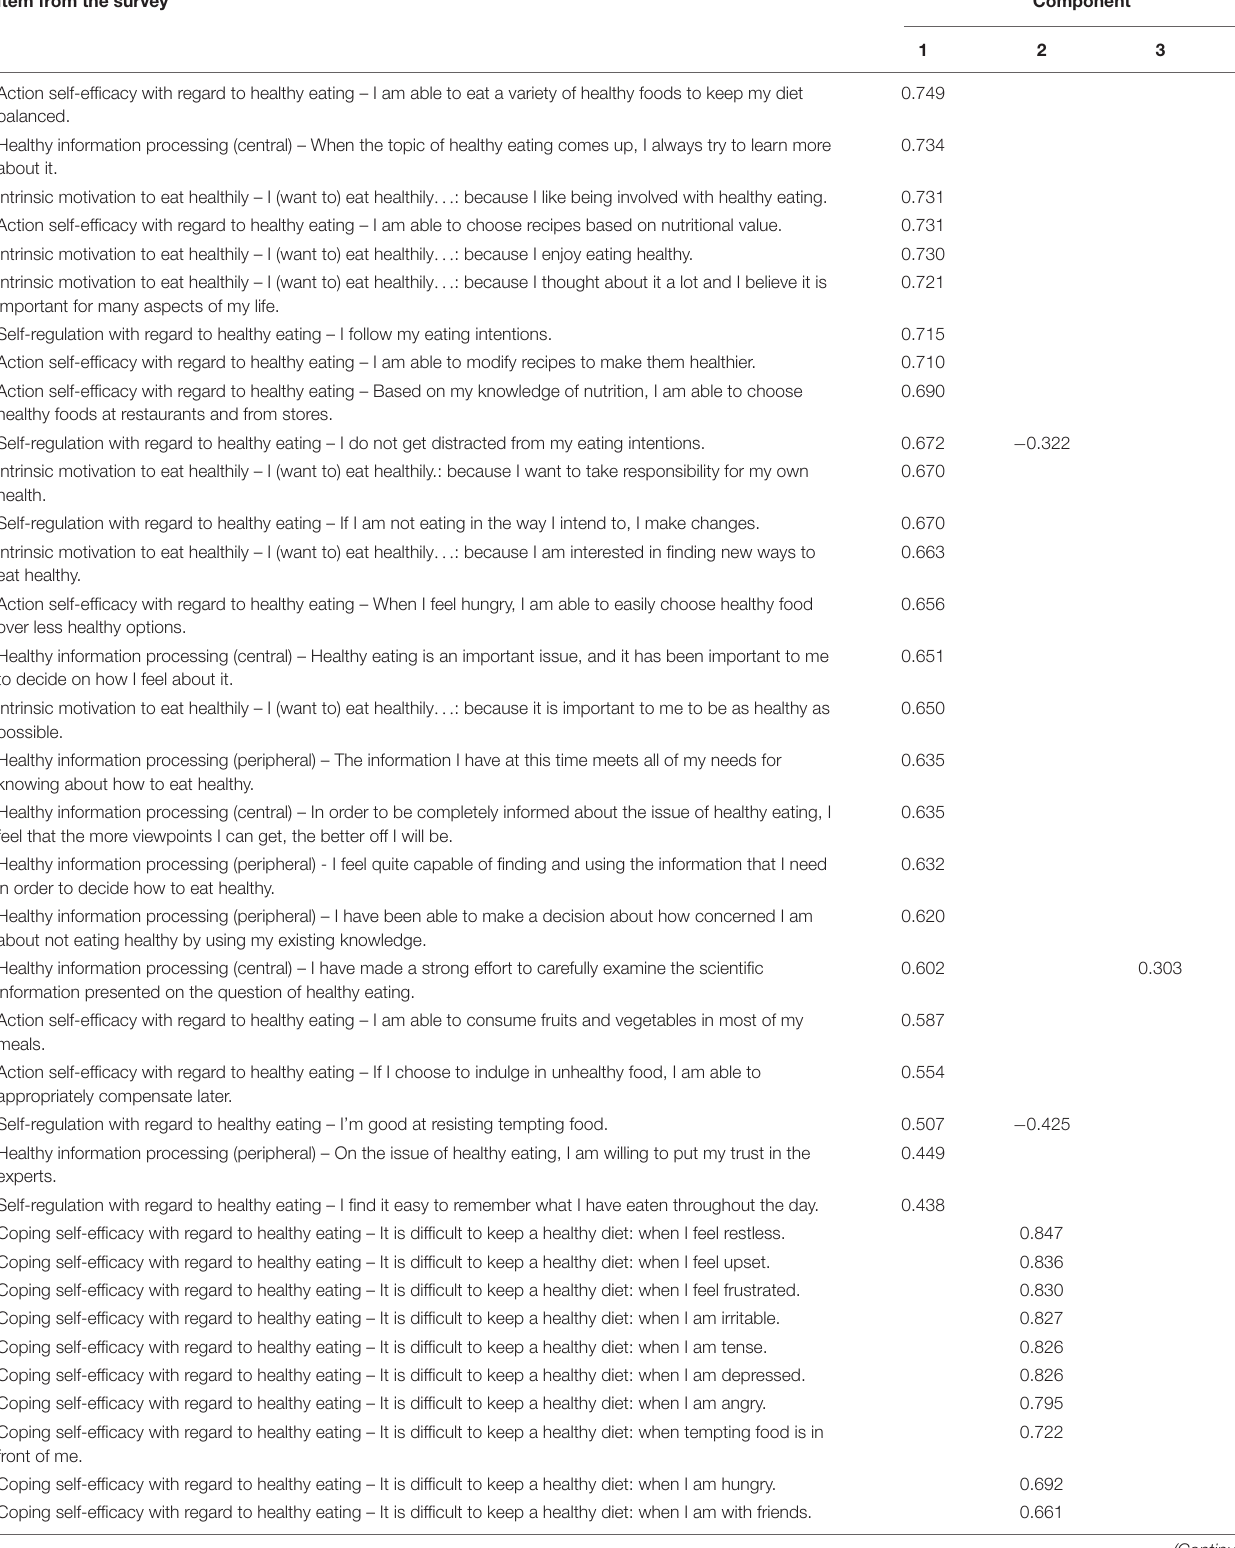
TABLE 2 | Loadings of items on the four